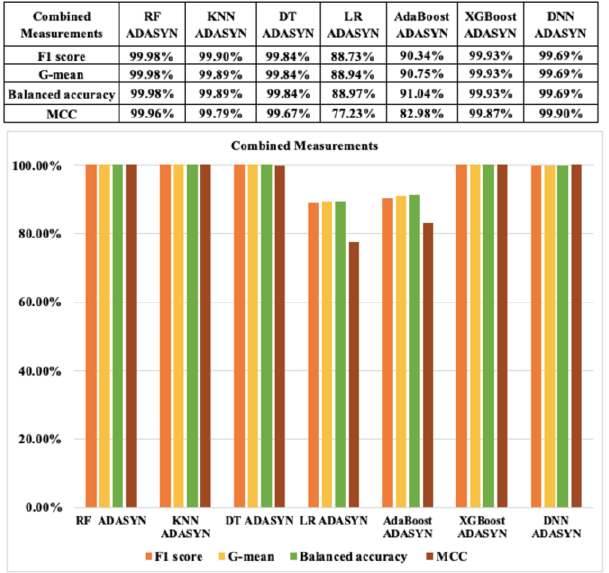
Figure 15. Combined classification performance measurements with ADASYN based on resampling approach 1.